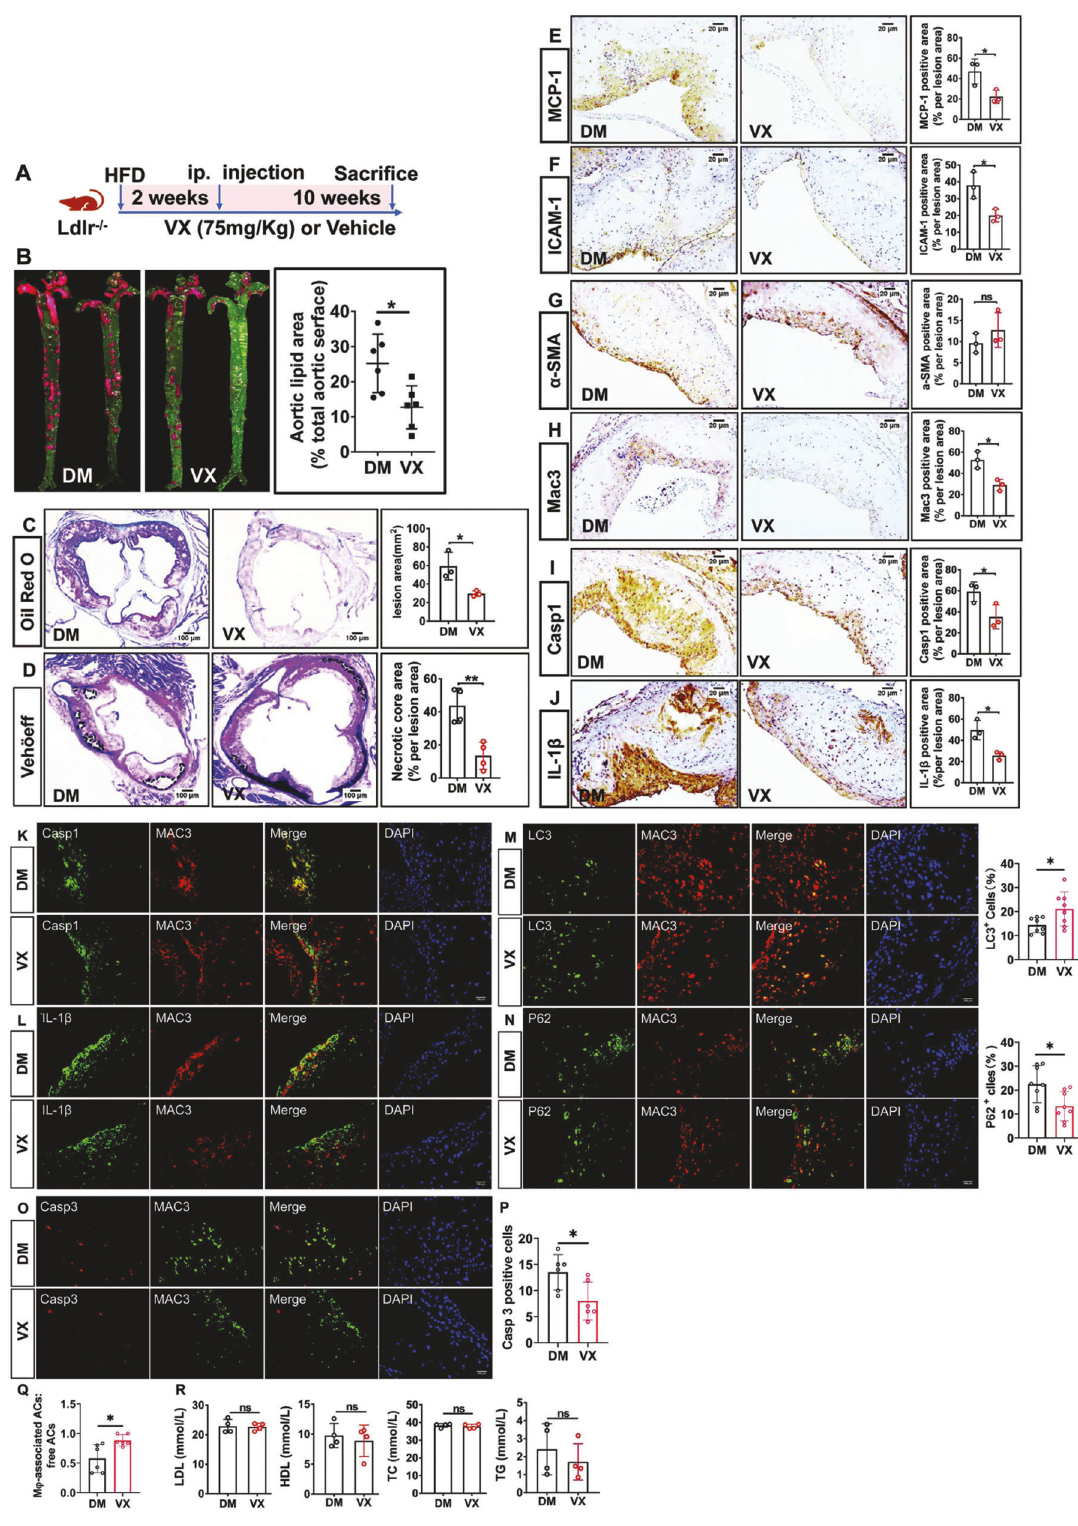
arginase 1 (Fig. 4J, K), two well-recognized markers of M2 macrophages [39]. In contrast, VX765 did not alter M1 polarization (Fig. 4J). Both macrophage migration [40] and proliferation [41] con- tribute to macrophage expansion in atherosclerotic plaques. We